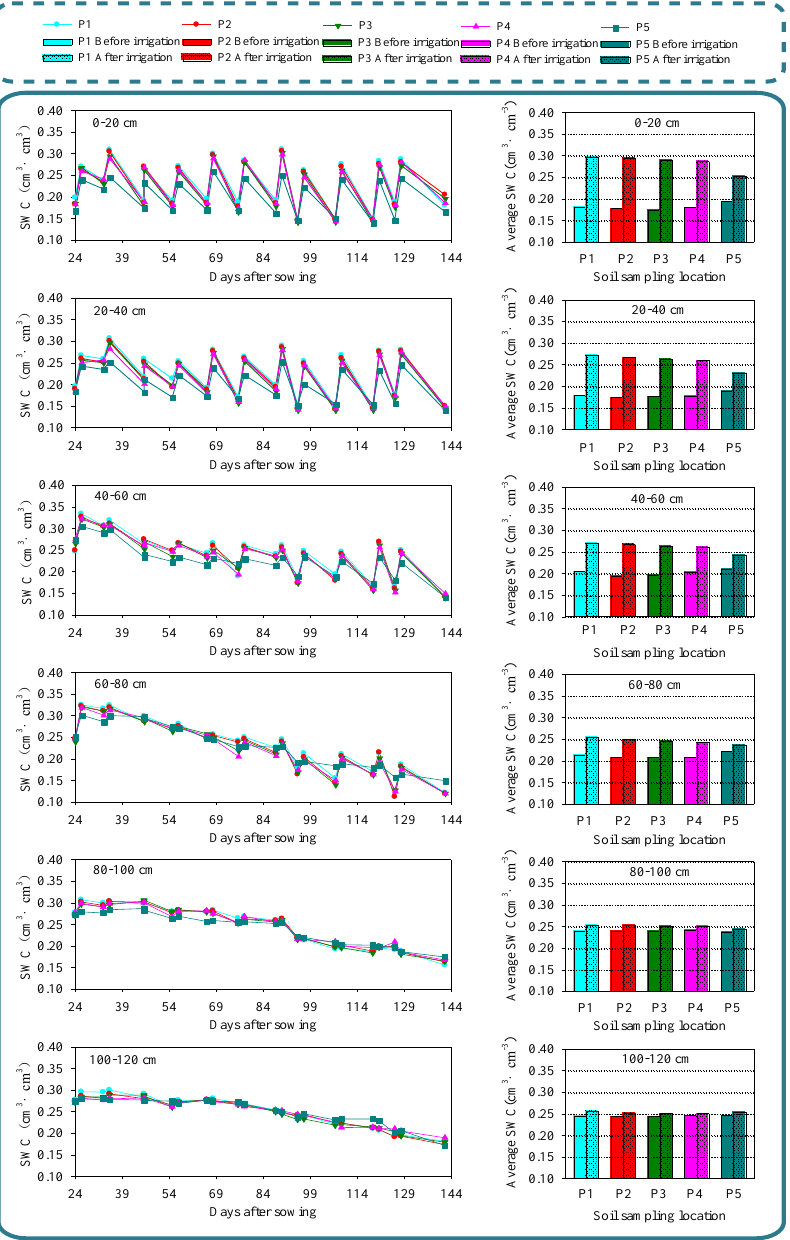
Figure 4. SWC in the 0–120 cm soil layers at full growth stage of spring maize in different irrigation and fertigation treatments in 2015.